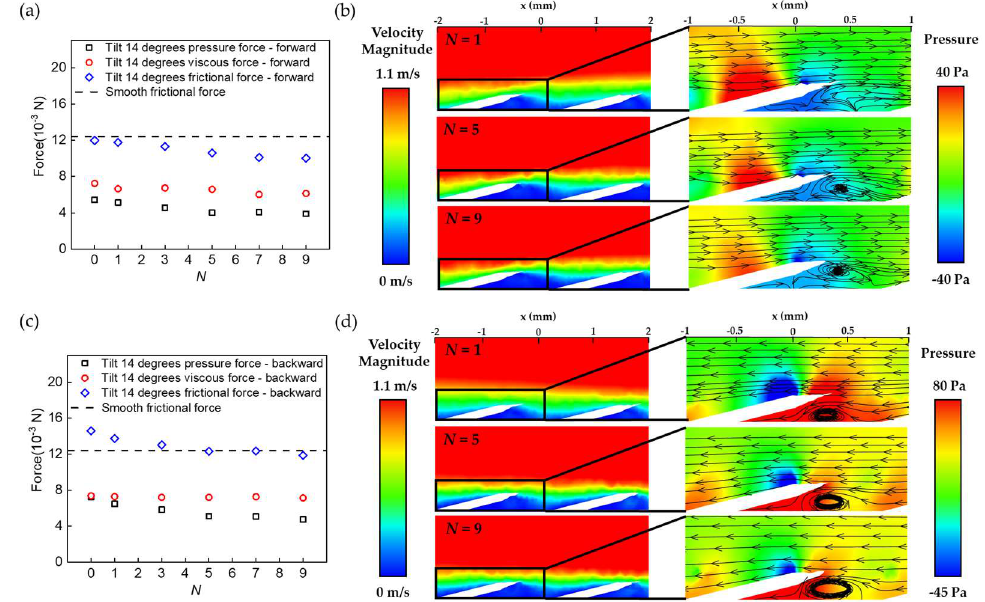
Figure 4. Mechanism of the bidirectional drag reduction. ( a ) The forces of BFTSS with different N in forward flow. ( b ) Velocity vector and streamline plots with different N in forward flow. ( c ) The forces of BFTSS with different N in backward flow. ( d ) Velocity vector and streamline plots with different N in backward flow.